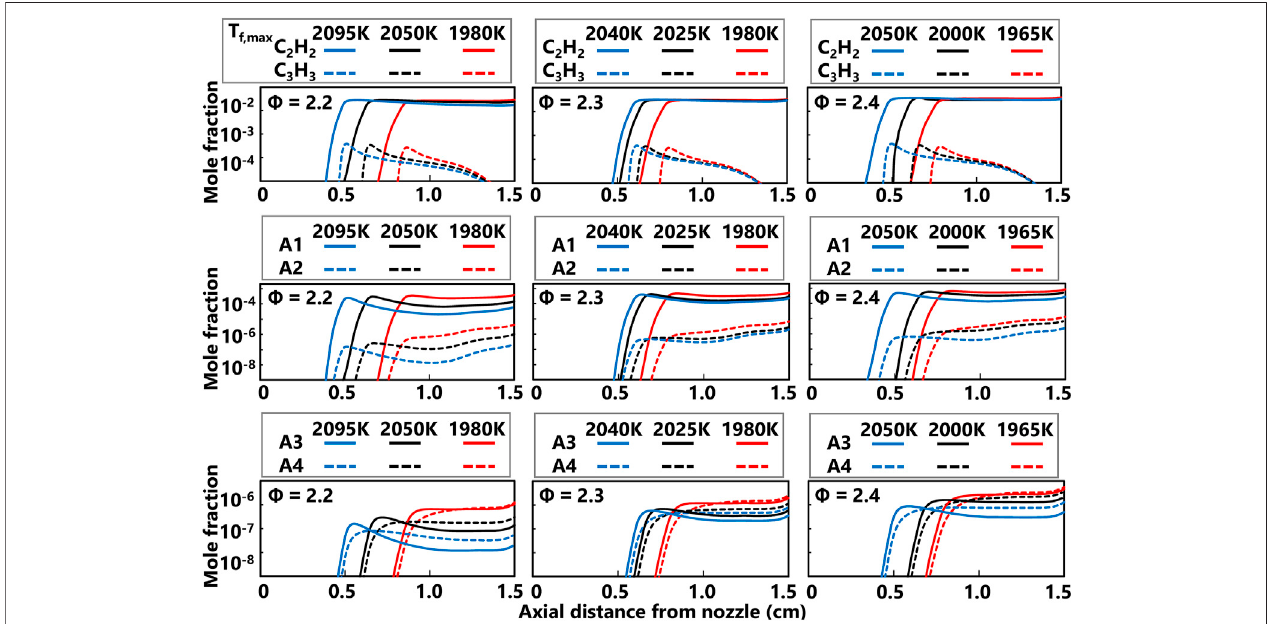
FIGURE 7 | Computed centerline axial pro fi les ofsoot precursors for the series of fl ames currently studied. The top row shows the production of acetylene (C2H2) and propargyl radical (C3H3), the middle row shows the production of benzene (A1) and naphthalene (A2), and the bottom row shows the production of phenanthrene (A3) and pyrene (A4).